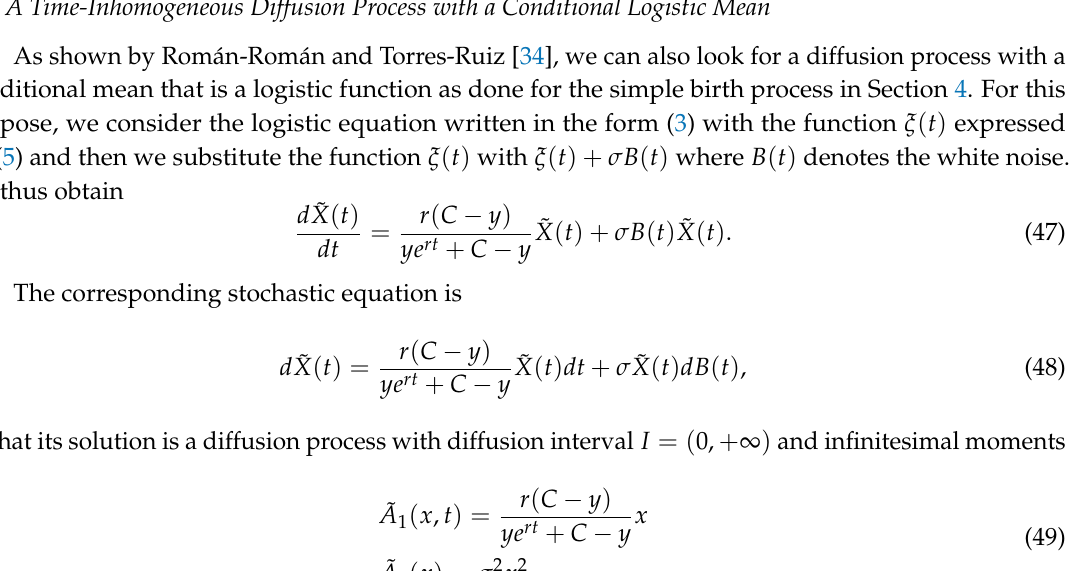
Figure 14. Fano factor ( a ) and the coefficient of variation ( b ) are plotted for C = 10, r = 1, σ = 1/3 and y = 1 (solid line), y = 0.5 (dashed